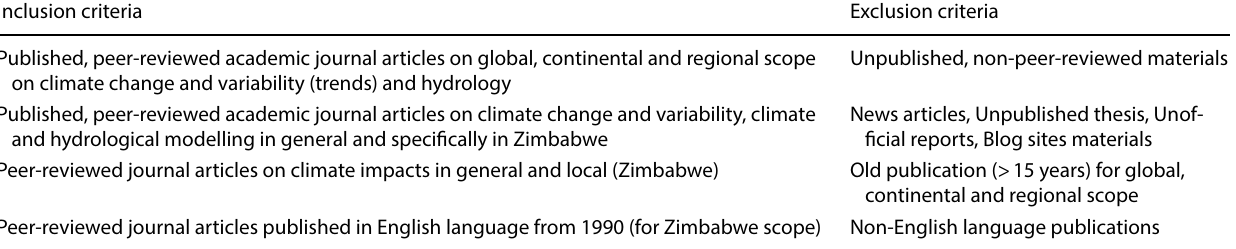
Fig. 1 Methodology flow diagram showing the main steps of the study approach. ( Adapted from Nichols et